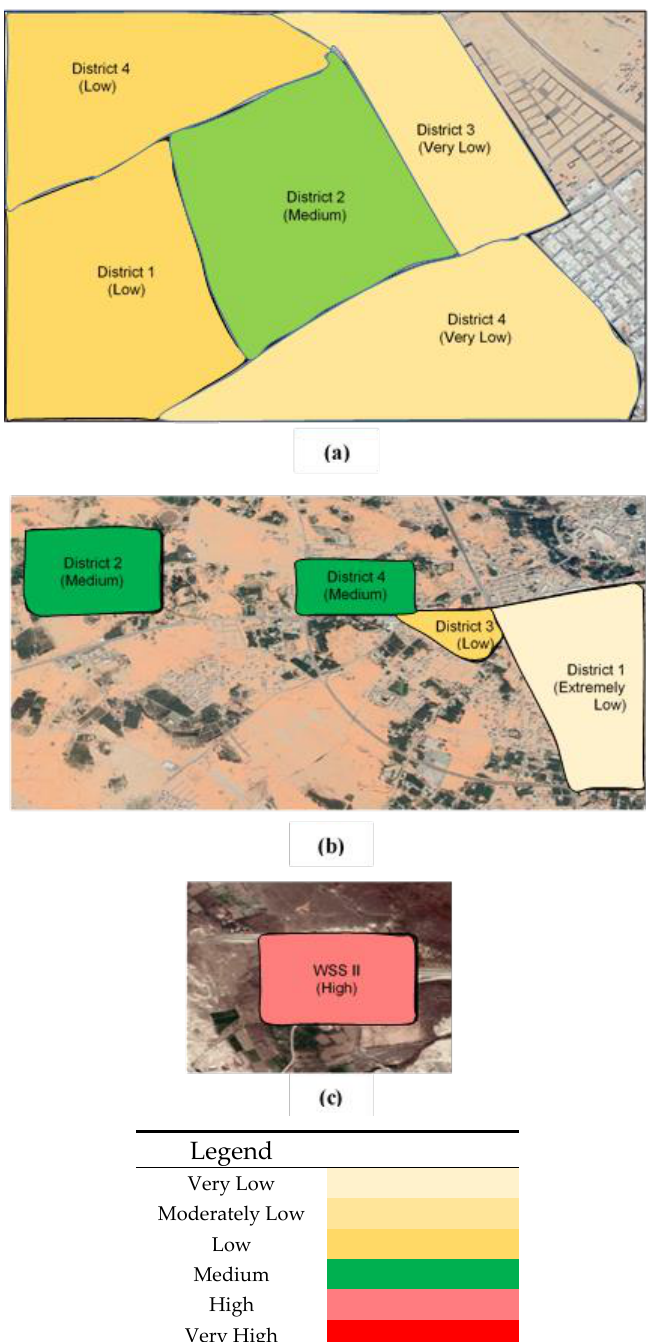
Figure 7. Risk mapping of water supply systems in study area. ( a ) Zone 1 of Water Supply System I, ( b ) Zone 2 of Water Supply System I, ( c ) Water Supply System II.